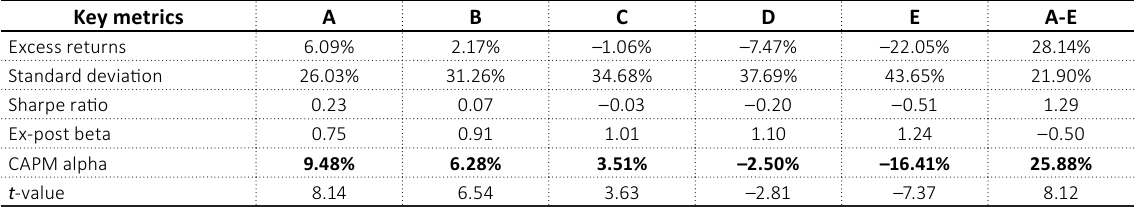
Table 12. Risk and return of dependent portfolios sorted on volatility and controlled for size